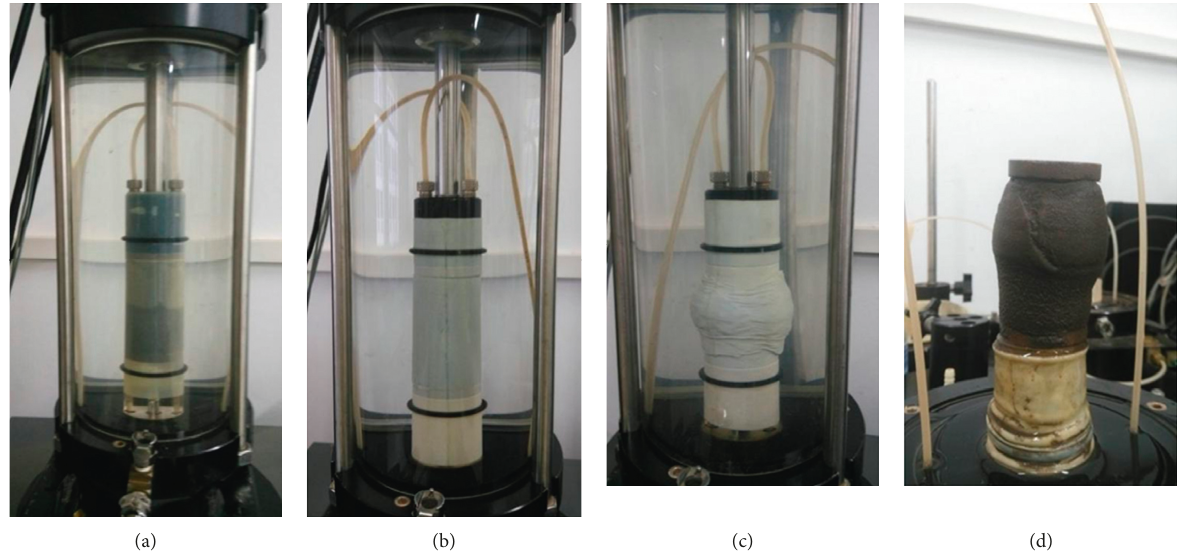
Figure 9: Procedure of the triaxial test: (a) setup of the specimen; (b) consolidation; (c) shearing; (d) dismantle of the specimen.